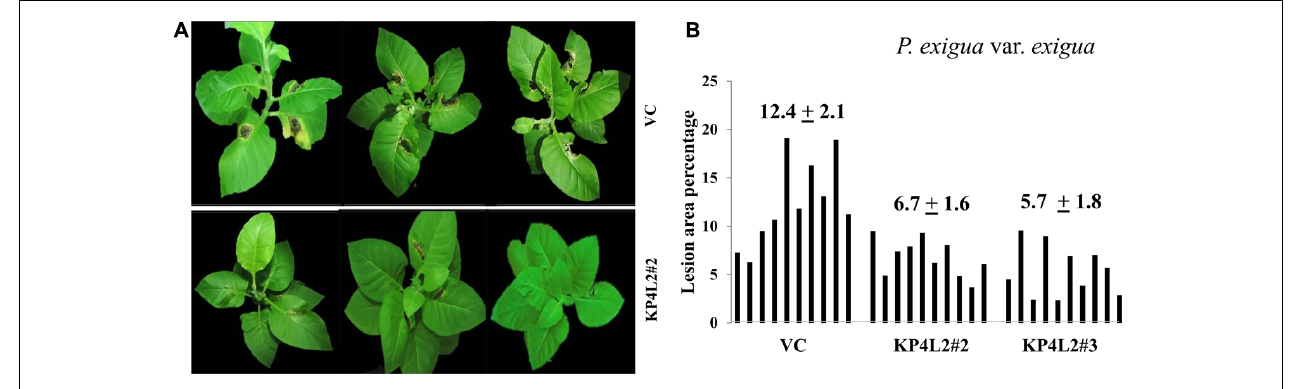
FIGURE 11 | Whole plant assays against P. exigua var. exigua . (A) Representative images of transgenic plant line KP4L2#2 along with VC 20 dpi. Ten plants each of KP4L2#2, KP4L2#3, and VC were wounded with a sterile needle and conidial suspension of the fungus (10 7 CFU/mL) was applied to initiate infection. (B) The graph represents percent lesion area ± SE calculated on the 20th